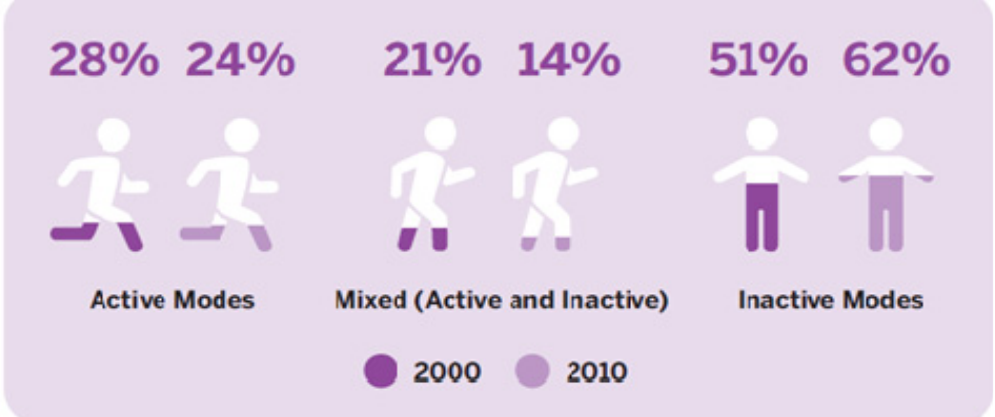
Figure 1. Usual modes of transportation among Canadian children and youth to/from school between 2000 and 2010